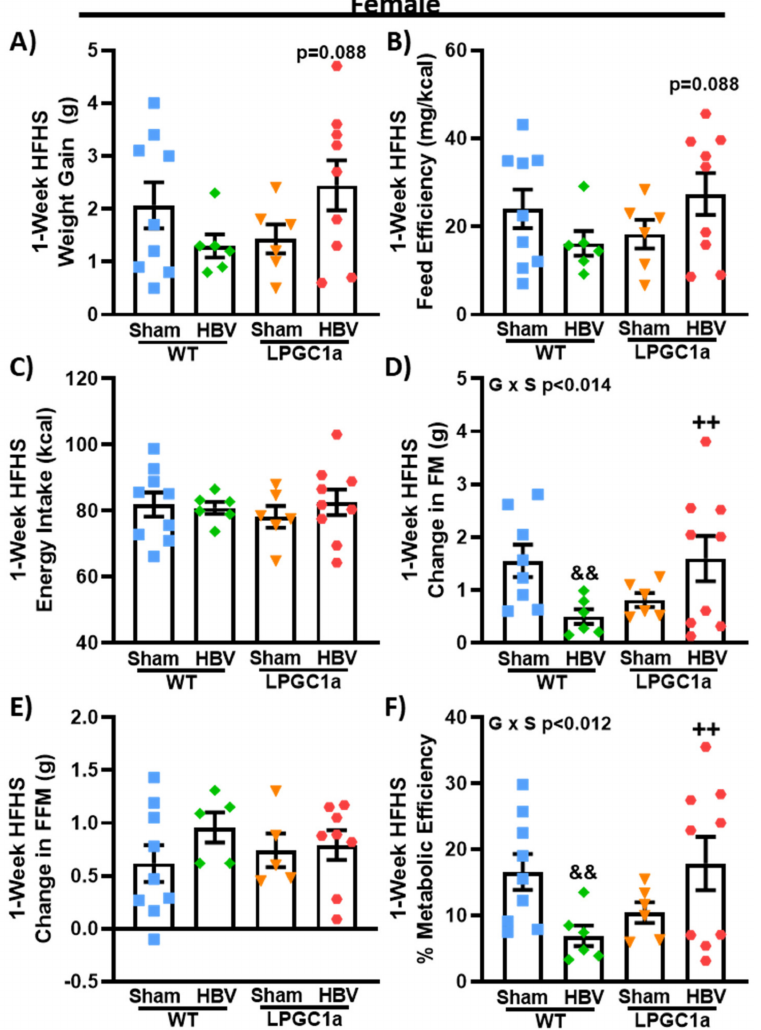
Figure 8. Common hepatic branch vagotomy reduces HFHS-induced fat mass gain in female WT, but not LPGC1a, mice. As with males, female WT and LPGC1a mice underwent sham or common hepatic branch vagotomy surgery. ( A ) Weight gain, ( B ) feed efficiency, ( C ) energy intake, change in ( D ) fat- and ( E ) fat-free mass, and ( F ) metabolic efficiency were determined following one week of HFHS feeding. Individual data points and the group means ± SEM are displayed (n = 6–9). Genotype x Surgery p < 0.05 interaction of genotype and surgery, && p < 0.05 sham vs. HBV within genotype, ++ p < 0.05 WT vs. LPGC1a within